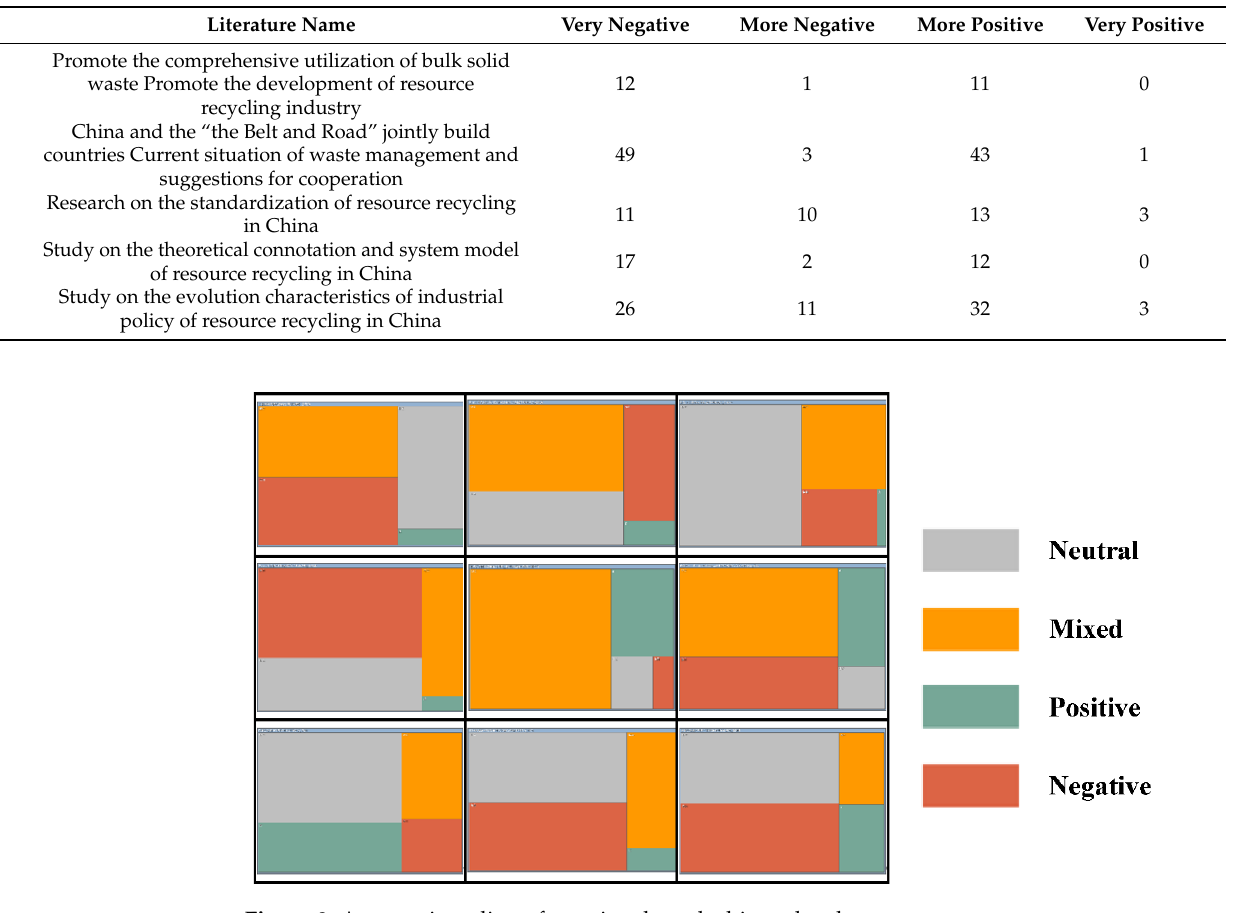
Figure 8. Automatic coding of emotional results hierarchy chart.